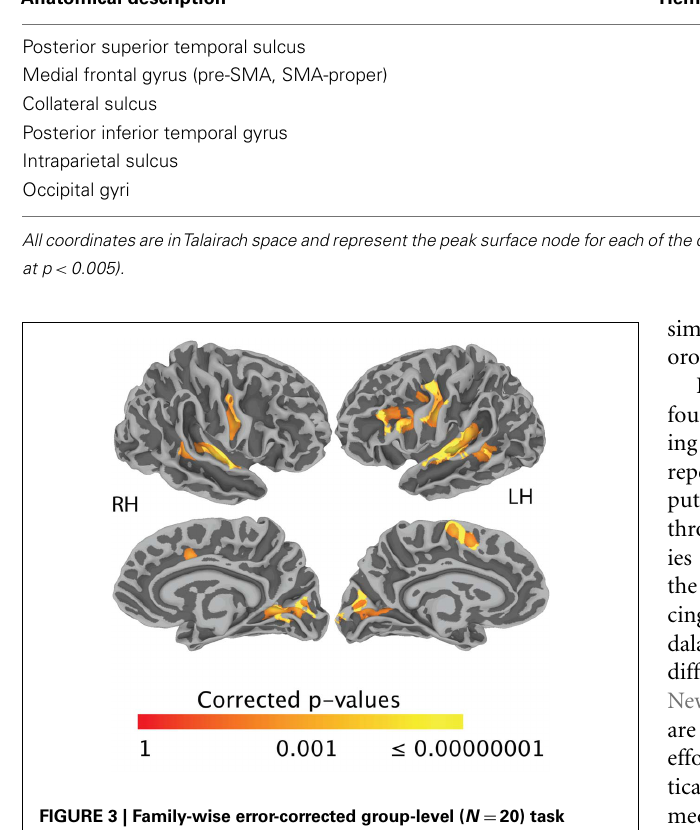
FIGURE 3 | Family-wise error-corrected group-level ( N = 20) task difference (generation > repetition). Activation is shown on the group average smoothed white matter folded